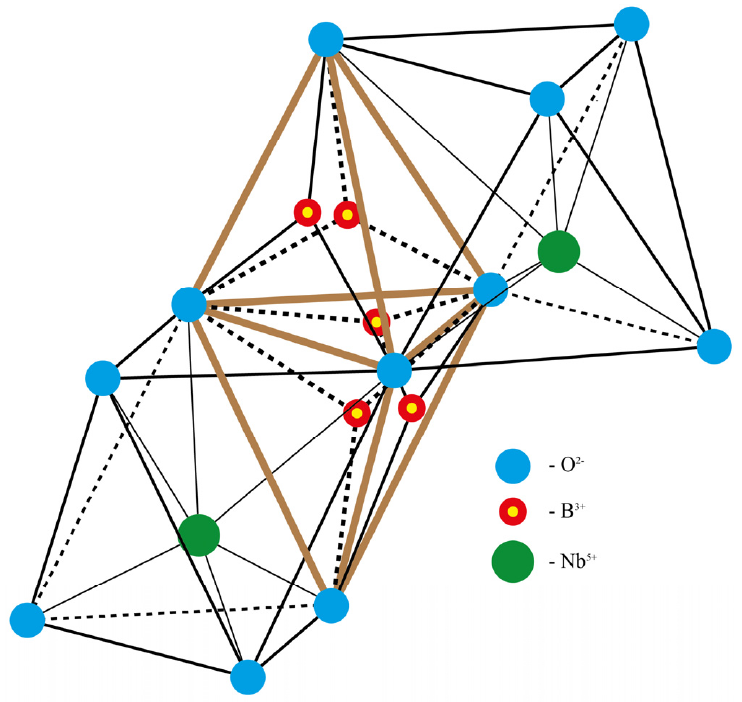
Figure 1. Most possible locations of B 3+ cation as a part of [BO 3 ] 3 − group: in tetrahedra faces formed by lithium or vacant O 6 octahedra; in a plane separating oxygen-tetrahedral layers.